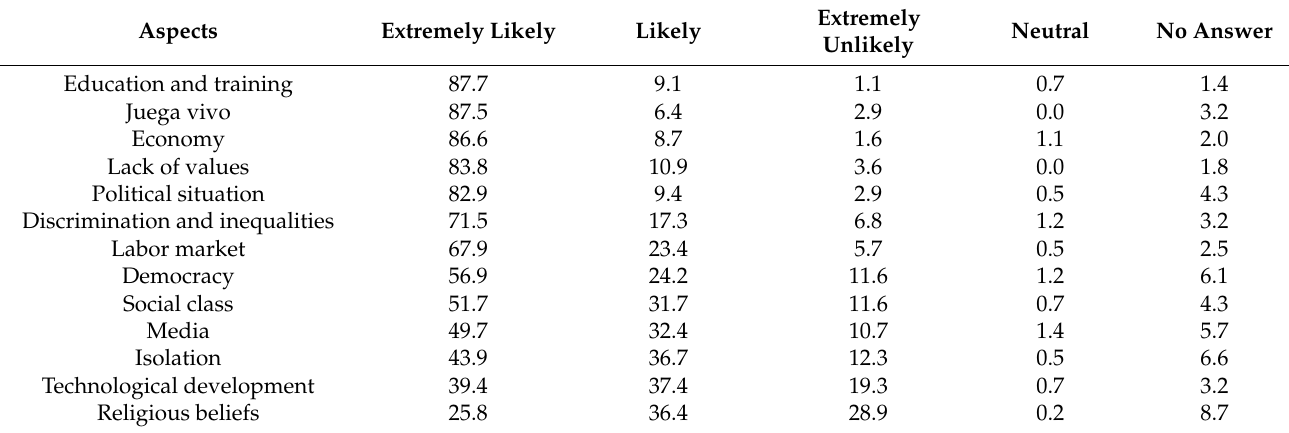
Table 11. Aspects that cause the crisis to